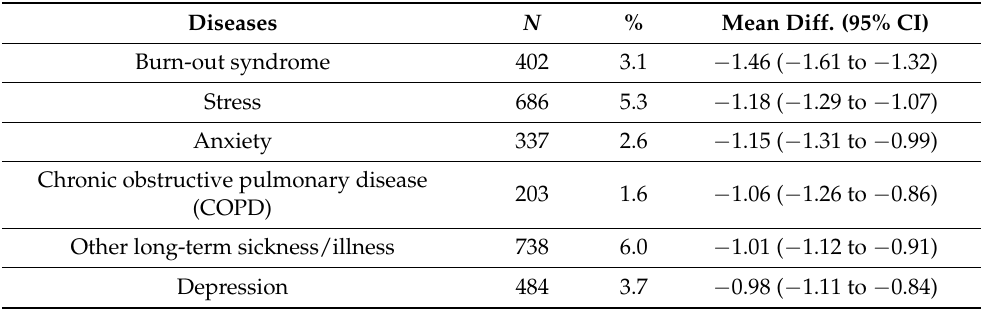
Table 2. Least square mean differences (Mean diff.) and 95% confidence intervals (95% CI) for work ability in different NCD compared with no NCD. Pooled for all workers